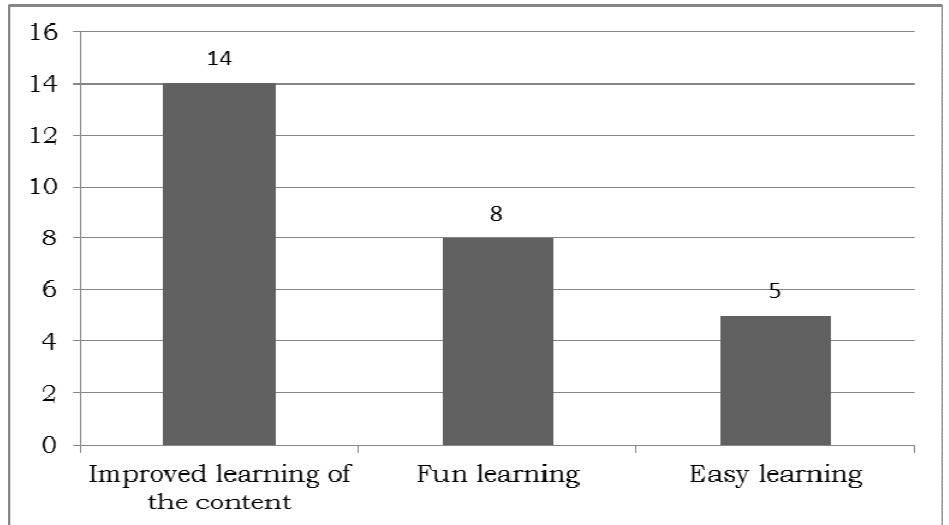
Figure 2. Three most mentioned by students about positive aspects of CLIL